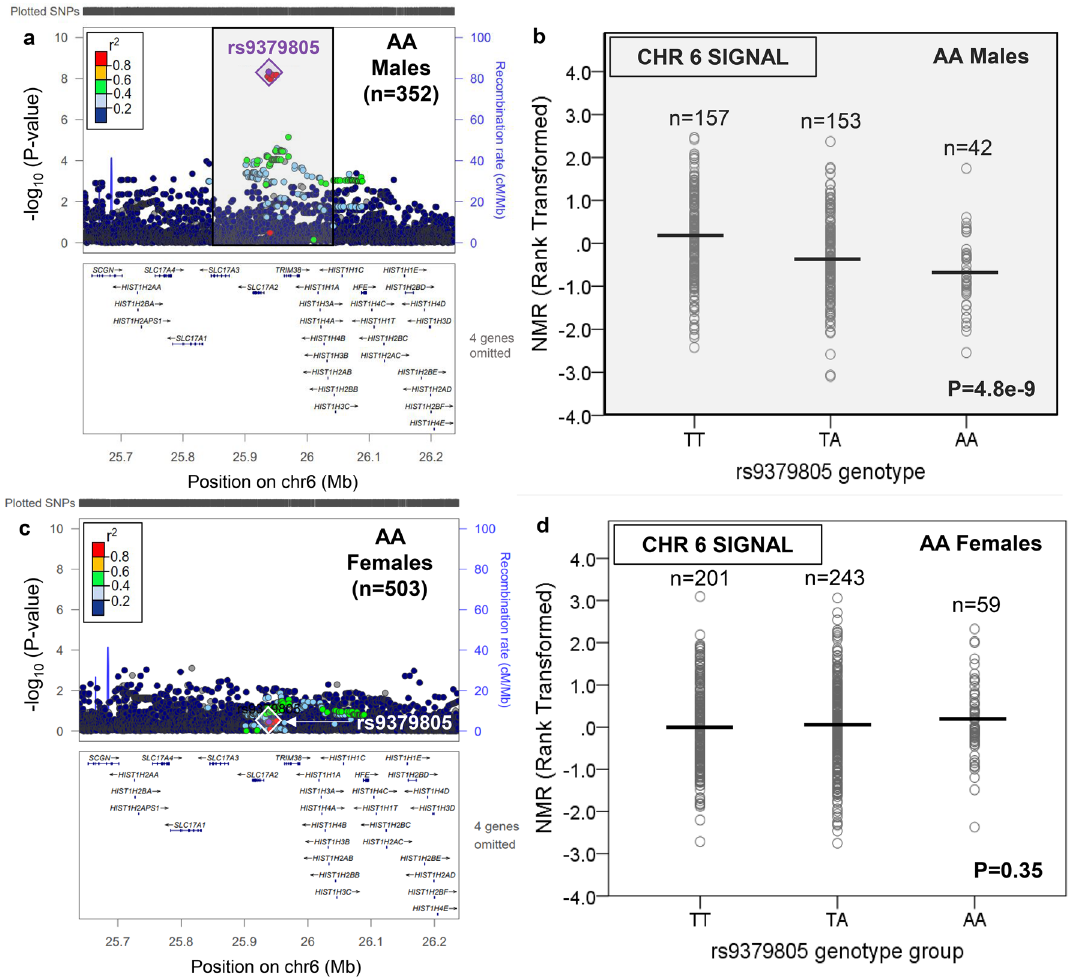
Figure 4. There was a chromosome 6 signal associated with the Nicotine Metabolite Ratio in African American males which was not significant in African American females. The nicotine metabolite ratio was rank- transformed for analysis. A regional plot, generated using LocusZoom 44 (freely available at locuszoom.org), shows the top overall chromosome 6 variant (rs9379805) in AA males (a); the influence of rs9379805 on the Nicotine Metabolite Ratio (NMR) in AA males is shown in ( b ). The chromosome 6 locus containing rs9379805 was not significant in AA females (c); the lack of influence of rs9379805 on the NMR in AA females is shown in ( d ). Linkage disequilibrium patterns in ( a ) and ( c ) are based upon the hg19/1000 Genomes November 2014 release African reference population. The plots in ( b ) and ( d ) were created using SPSS version 23 (can be purchased from IBM, Armonk, New York, USA). The black horizontal line represents the mean